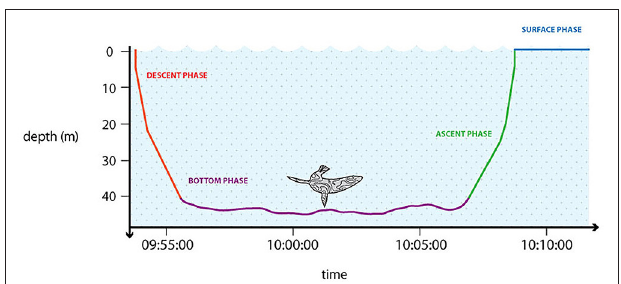
FIGURE 3 | Stylized graphic representation showing a general dive of a marine predator. The diving phases are summarized using different colors: descent phase (red); bottom phase (violet); ascent phase (green); surface phase (blue). Designed by: Charlie